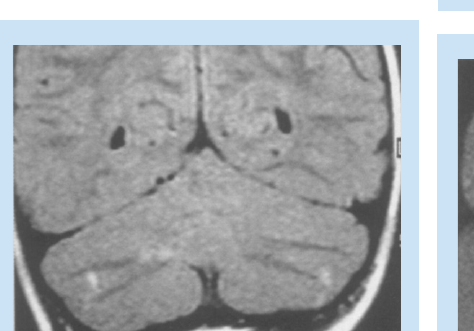
Fig 2b. Axial gadolinium-enhancement T1-weight- ed image at the same level showing an enhancing plexiform neurofibroma within the lateral aspect of the orbit (arrow).